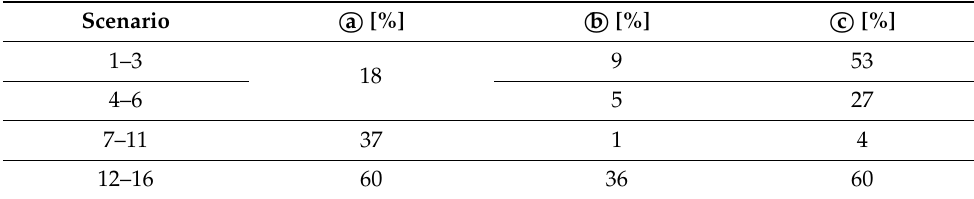
Table 2. Ratio considering the DG